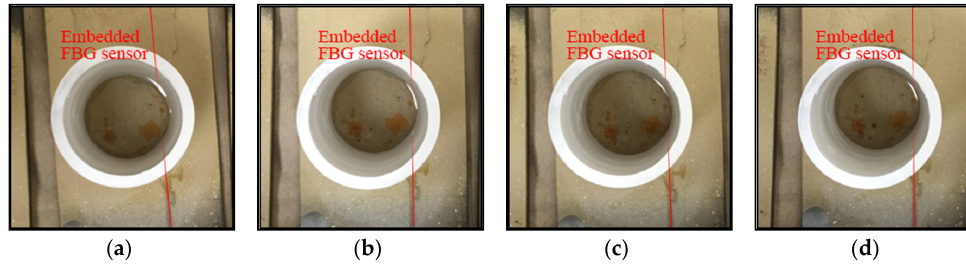
Figure 16. Visual inspections of Sample #3. ( a ) Day 1; ( b ) Day 2; ( c ) Day 3; ( d ) Day 6.